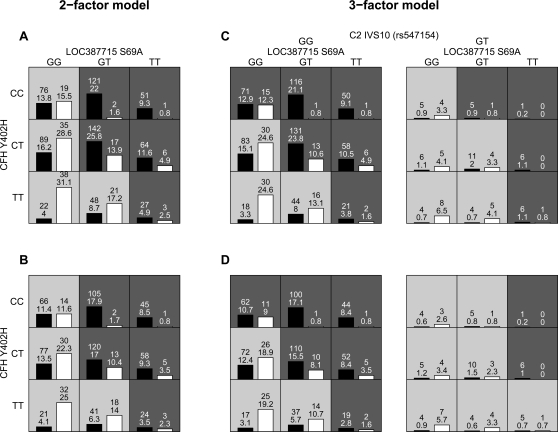
Results of GMDR analyses.A: Results of unadjusted GMDR analysis for the best two-factor model. B: Results of adjusted GMDR analysis for the best two-factor model. C: Results of unadjusted GMDR analysis for the three-factor model. D: Results of adjusted GMDR analysis for the three-factor model. Dark grey and light grey boxes correspond to the high- and low-risk genotype combinations, respectively. The black and white bars within each box correspond to cases and controls, respectively. The top number above each bar is number of individuals and the bottom number is the sum of scores for the corresponding group of individuals (cases or controls with particular three-locus genotype). The heights of the bars are proportional to the sum of scores in each group.